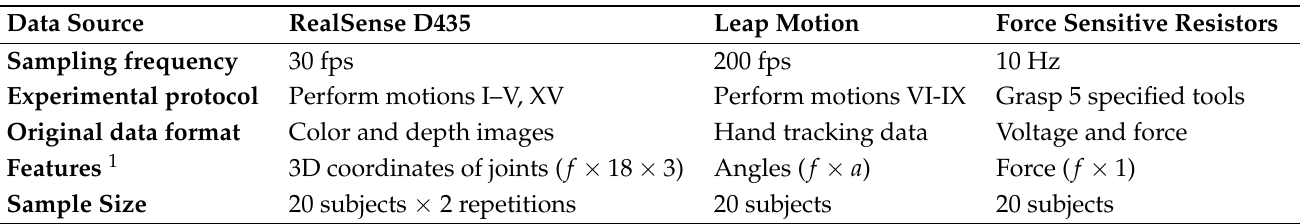
Table 2. Raw data